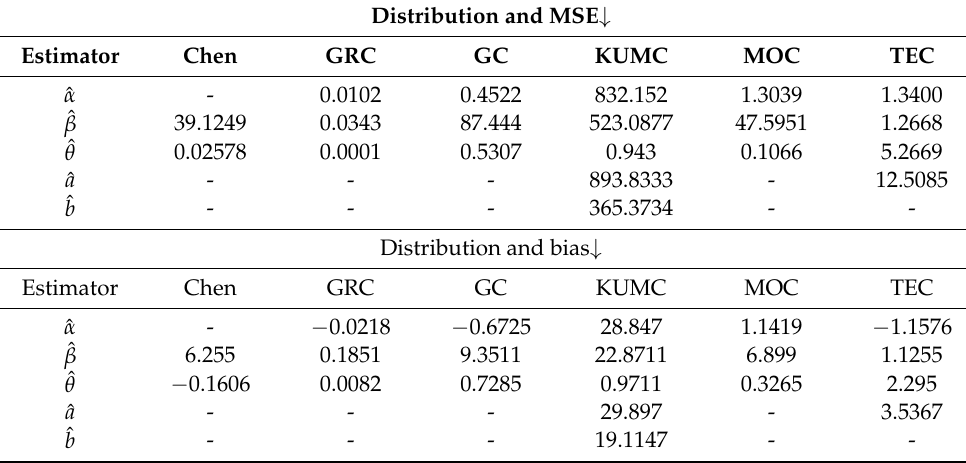
Table 16. Results for samples generated from the GRC distribution with n =